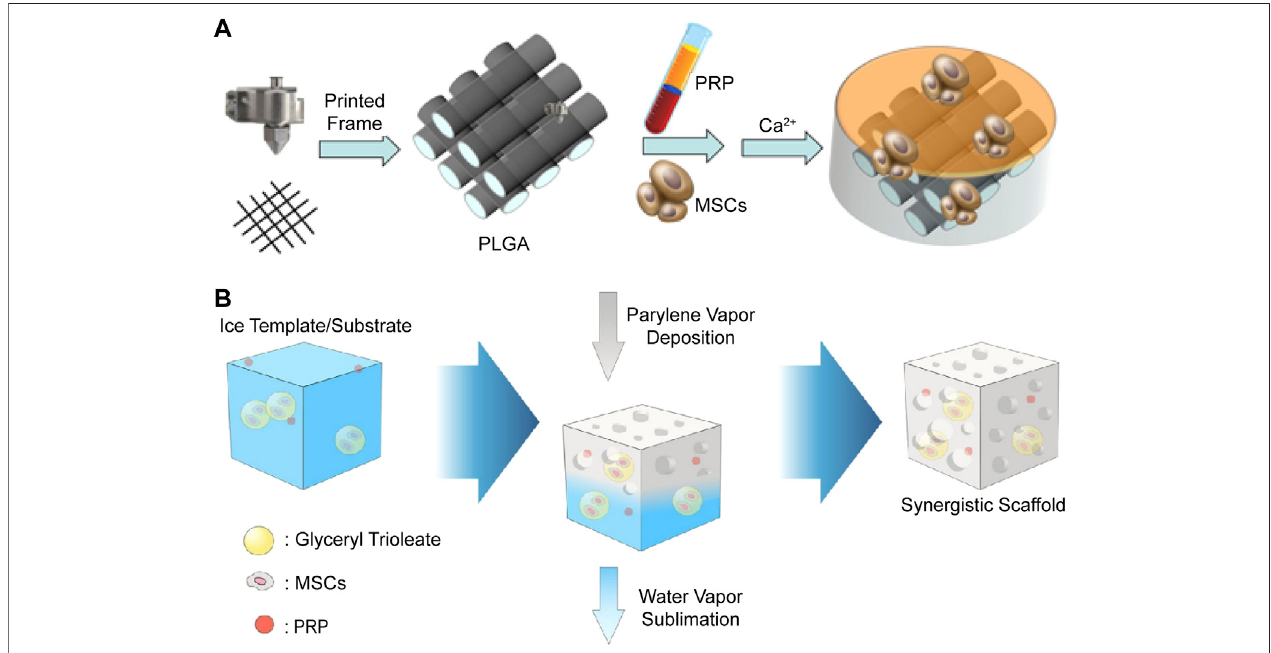
FIGURE5| Schematicillustrationoftwomethodstoaddplateletderivativesintothescaffolds. (A) 3DprintedPLGAframesareimmersedinMSC-suspendedPRP solution, and then the gelation of PRP is induced by addition of CaCl 2 solution with thrombin to complete the CTE construct. Reproduced with permission from Tang Y. et al. (2021). (B) Biomaterials, MSCs, and PRP are all mixed together before fabrication process to construct the synergistic scaffold. Reproduced with permission from Wu et al. (2020a).